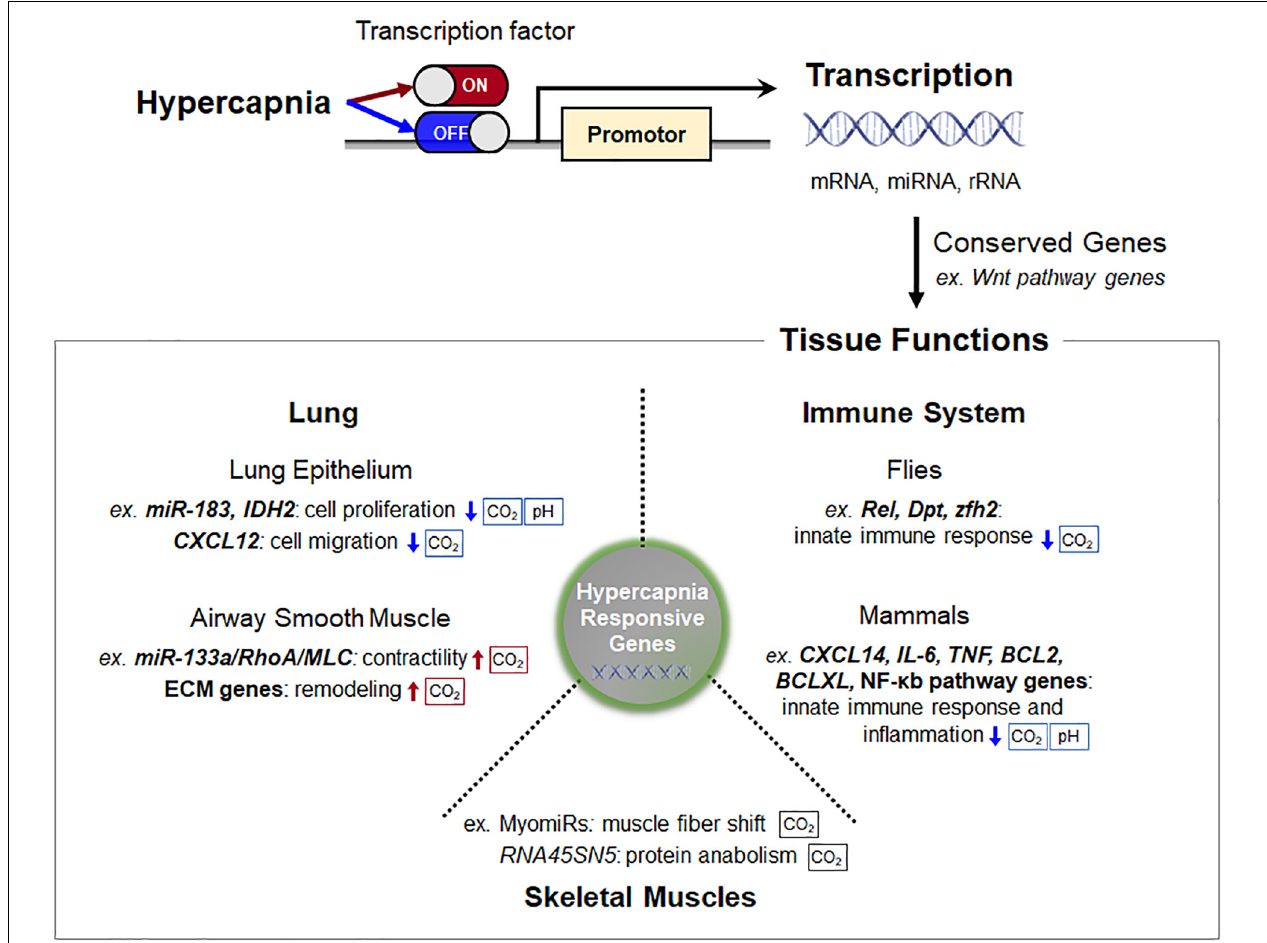
FIGURE 2 | Schematic of transcription regulation and consequent tissue functions in hypercapnia. Cells, tissues, and organisms possess a complex transcriptional program that selectively promotes certain genes while simultaneously attenuating translational activity in response to elevated CO 2 levels. Some of the hypercapnia-responsive genes, particularly Wnt pathway genes, are evolutionarily conserved in different cell types, tissues, and species. The sensing pathways that are pH-dependent are indicated. Abbreviations: IDH2, isocitrate dehydrogenase-2; CXCL12, C-X-C motif chemokine 12; MLC, myosin light chain; ECM, extracellular matrix; RNA45SN45, ribosomal 45S pre-RNA; Rel, Relish; Dpt, diptericin; zfh2, Zn finger homeodomain 2; TNF, tumor necrosis